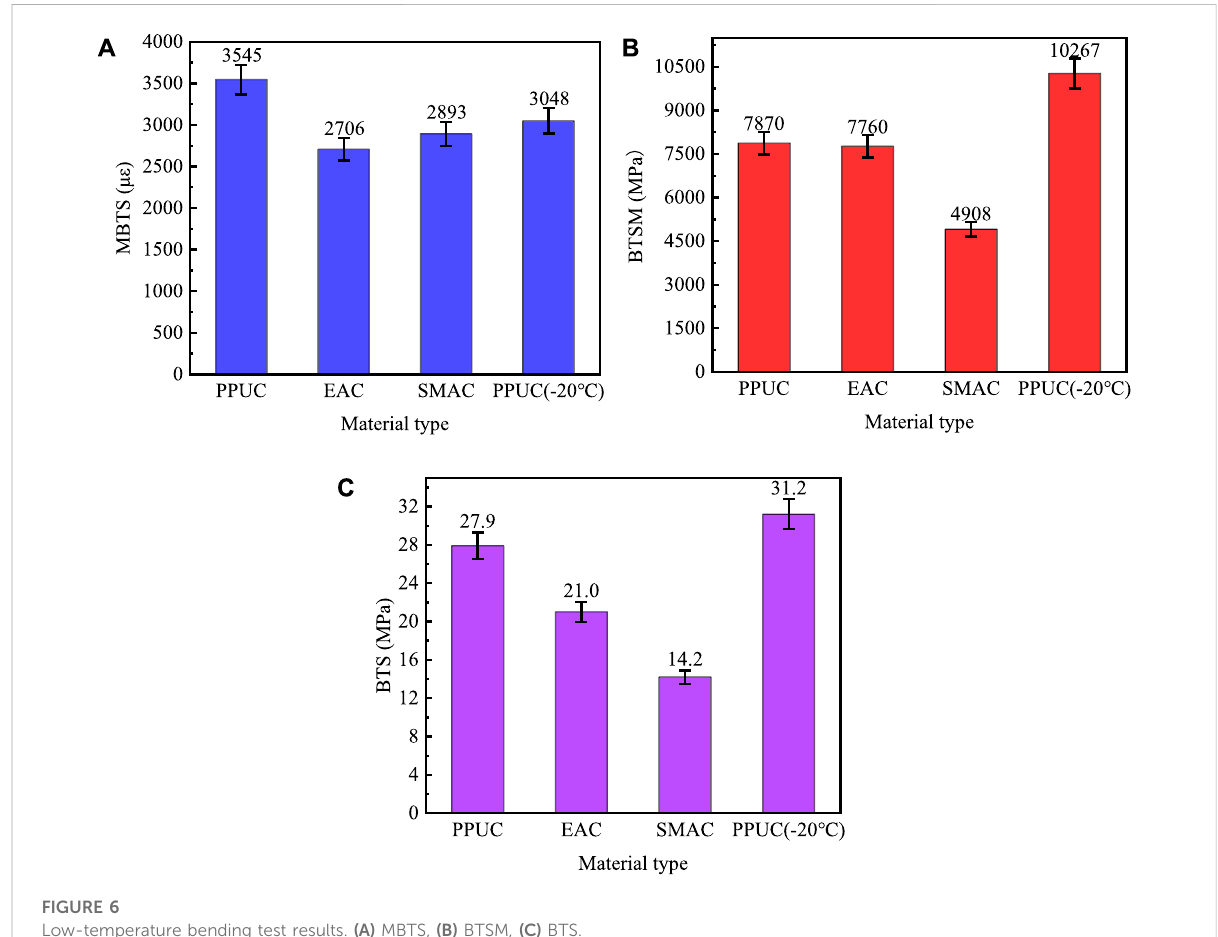
FIGURE 6 Low-temperature bending test results. (A) MBTS, (B) BTSM, (C) BTS.